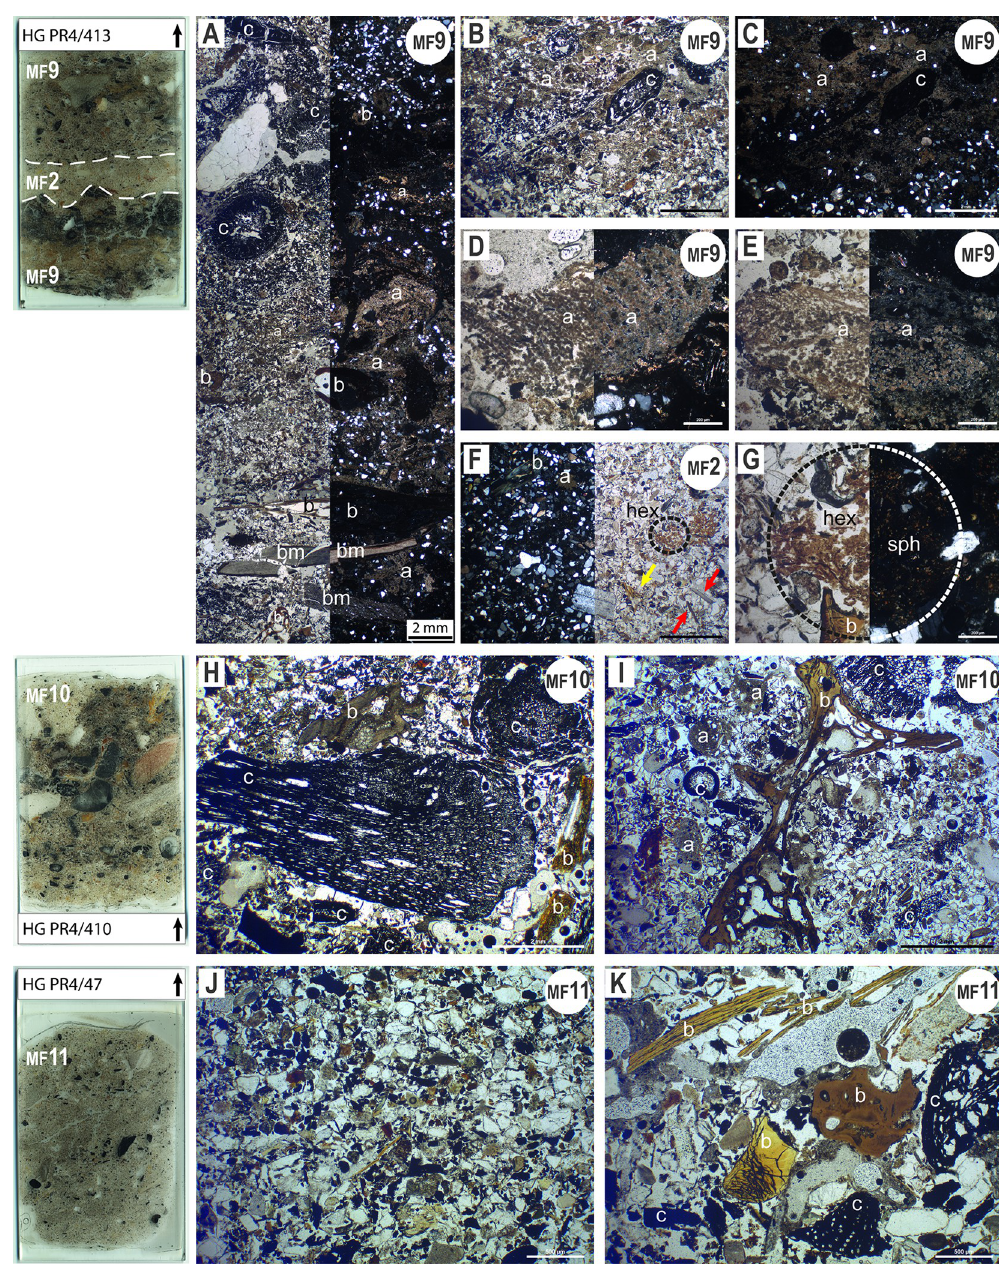
Fig 8. Photomicrographs of thin-sections representing microfacies related to combustion features and waste (MF9 to MF11). Sample 4/413 : the dashed lines represent the borders between different MF-type layers. MF9 deposits are formed by pairs of stacked, thin, black and yellow layers. Note the layer of occupation deposits (MF2) identified between two distinct burning episodes. A : MF9 layers contain charcoal (c), burnt shells (bm) and bones (b) as well as ash crystals (a) (left half in PPL; right half in XPL). B and C : In the yellow layer at the base of the sample, ash crystals surround charcoal fragments. Photomicrograph B was taken in PPL while C was taken in XPL. D and E : Some burnt vegetal tissues still preserve their original structure (XPL left half; PPL right half). F : The MF2-type layer contains some unburnt bone fragments (yellow arrow), mollusc shells (red arrows) and herbivore excrement (dotted circle) (XPL left half; PPL right half). G : The same view as F, at higher magnification (PPL left half; XPL right half). Herbivore excrement is easily recognisable in XPL by the presence of spherulites. A fragment of unburnt bone is visible at the bottom of the picture. H and I : In the MF10 deposits, large pieces of charcoal and bones are present. Some ash crystal aggregates are also visible (both photos were taken in PPL). J : The MF11 layers show a finer texture compared with the MF10 deposits. Aeolian sans are very common, mixed with small ( < 1 mm) charcoal fragments and food remains (PPL). K : The same view as J, at higher magnification (PPL). Some bone and charcoal fragments are visible.